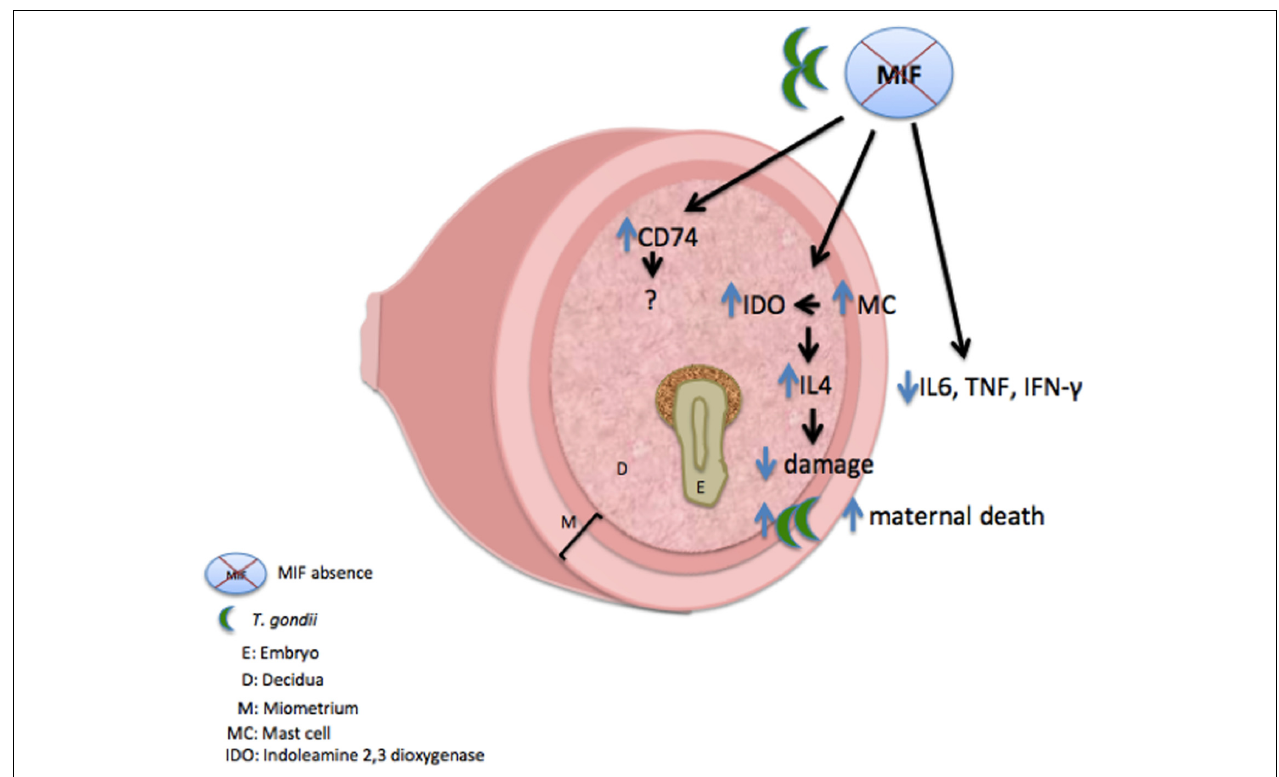
FIGURE 9 | Proposed scheme for the immune response mechanism to congenital toxoplasmosis in C57BL/6 MIF − / − females. C57BL/6 MIF − / − pregnant females (8 dop) infected by T. gondii presented upregulation in MIF receptor (CD74), as a possible compensatory mechanism for MIF absence. Additionally, these mice presented increased MC recruitment at the maternal fetal interface that can be associated with increased IDO expression at this interface. IDO upregulation is probably associated with increased IL-4 expression in these tissues. Likewise, C57BL/6 MIF − / − females presented a decrease in systemic proinflammatory cytokines. Altogether, these data clarify that the effects on pregnancy outcome are less harmful in C57BL/6 MIF − / − females but still indicate T. gondii proliferation and early death in these